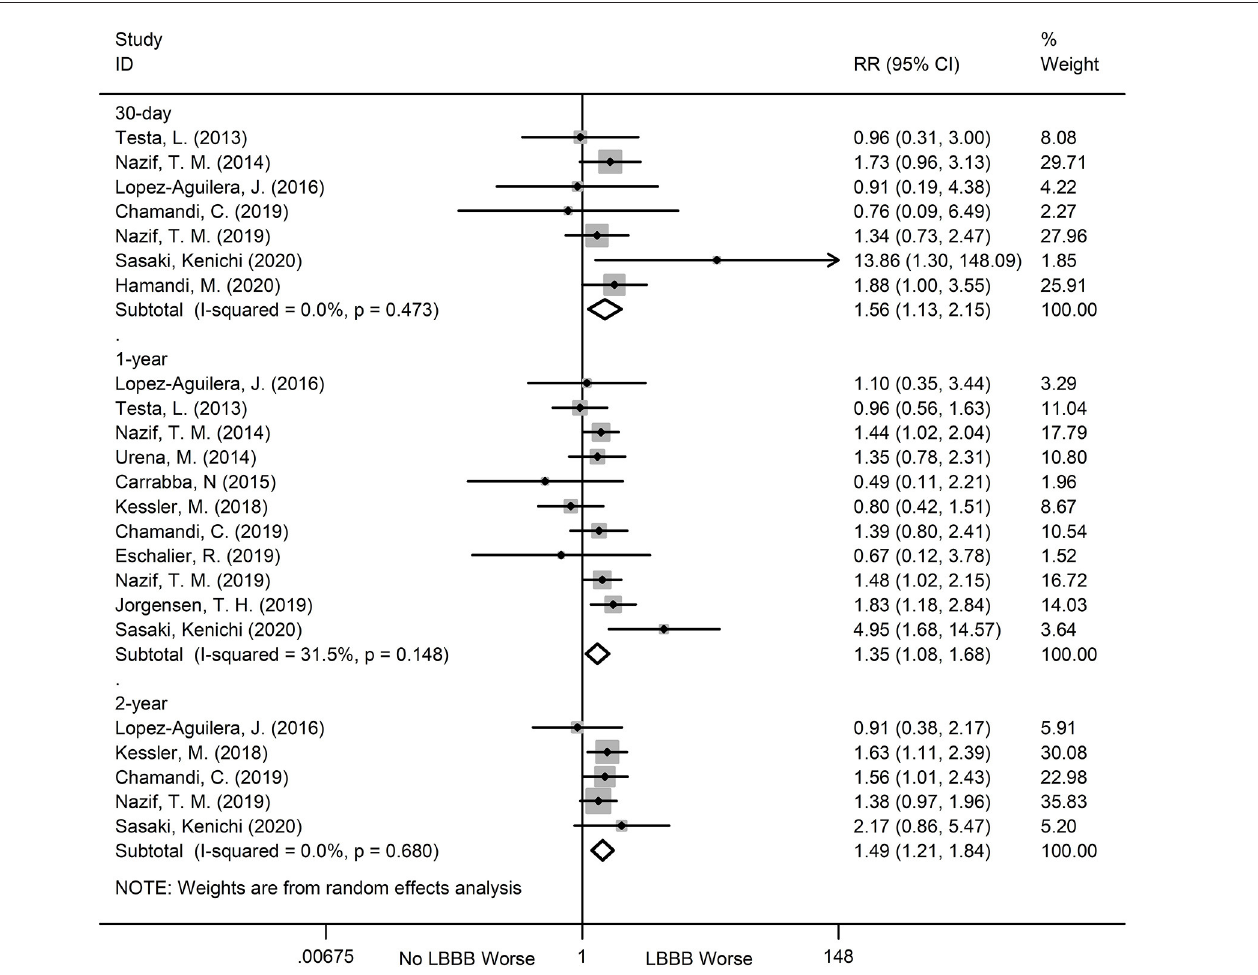
FIGURE 5 | Forest plot comparing hospitalization for heart failure risk between patients with andwithout new-onset LBBB after